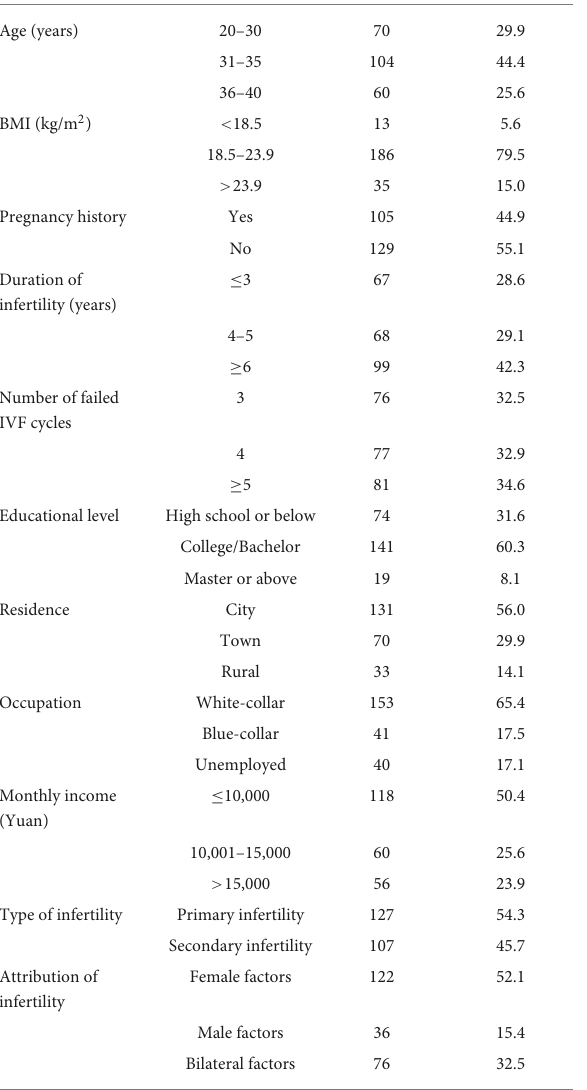
TABLE 1 Demographic characteristics of infertile women with repeated implantation failure (RIF).